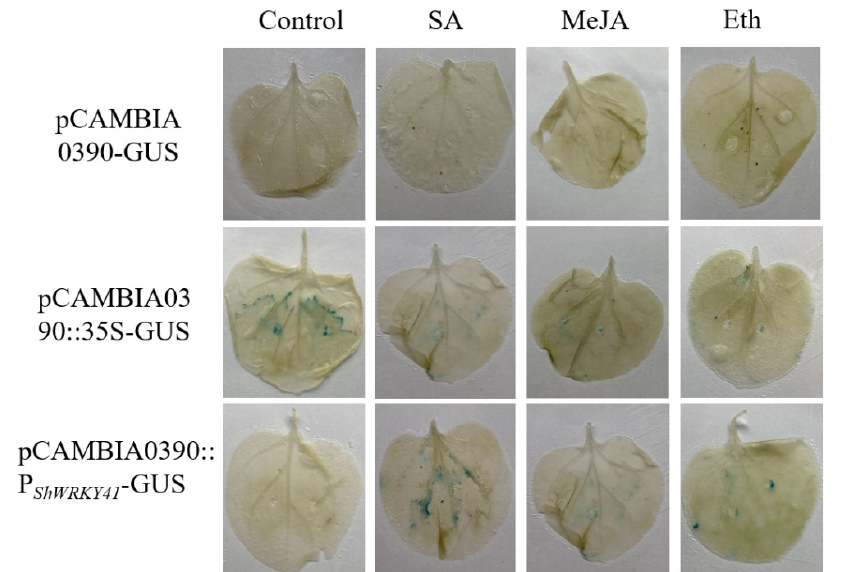
Figure 4. The GUS analysis of wild tomato ShWRKY41 promoter. Histochemical GUS assay was performed in the transient expression N. benthamiana , which were cultivated in a 22 °C chamber with 16 h light/8 h dark cycle for 2 days after the treatment with 100 mM MeJA, 10 mM SA, 0.5 mM ACC (1-aminocyclopropanecarboxylic acid, the ethylene precursor) (Sigma, Shanghai, China) , and water (Control), respectively.